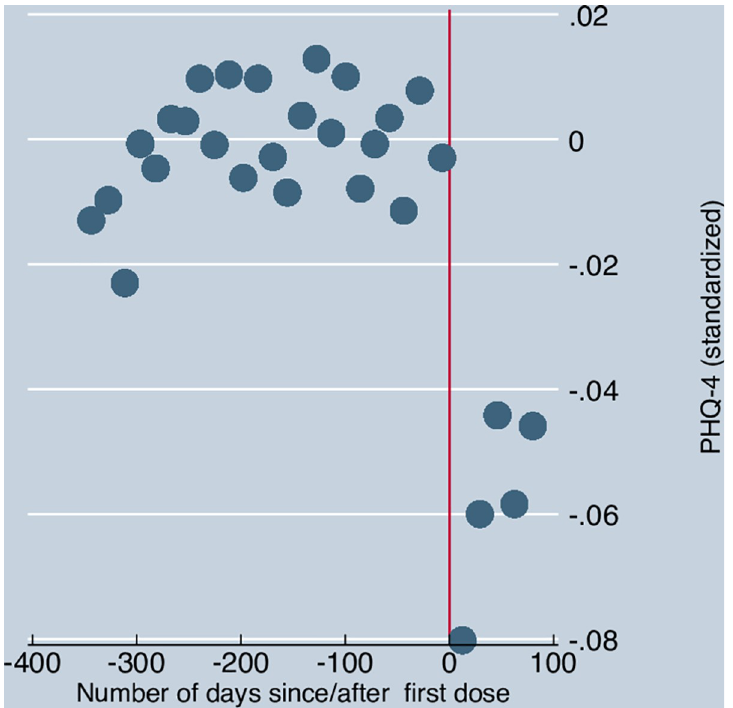
Fig 2. Mental distress before and after receiving the first dose. Note. PHQ-4 scores are standardized to have a mean of 0 and a standard deviation of 1. Residuals are taken from a linear regression of standardized PHQ-4 scores against wave dummy variables and an indicator for ever vaccinated . For the ever vaccinated , the residual is plotted against the number of days before or since receiving the first dose. Observations are grouped by wave. Vertical line denotes the date when a vaccination dose was first reported.